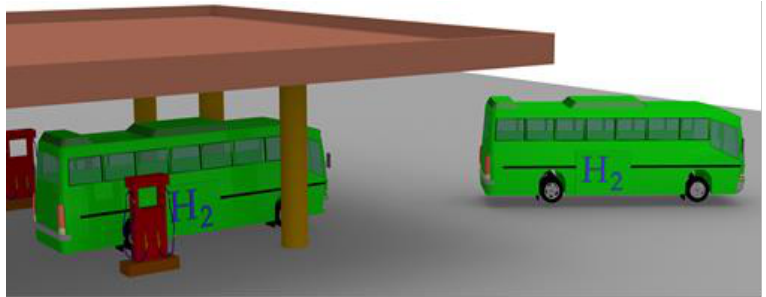
Figure 7. Rendering image of hydrogen fuel station.